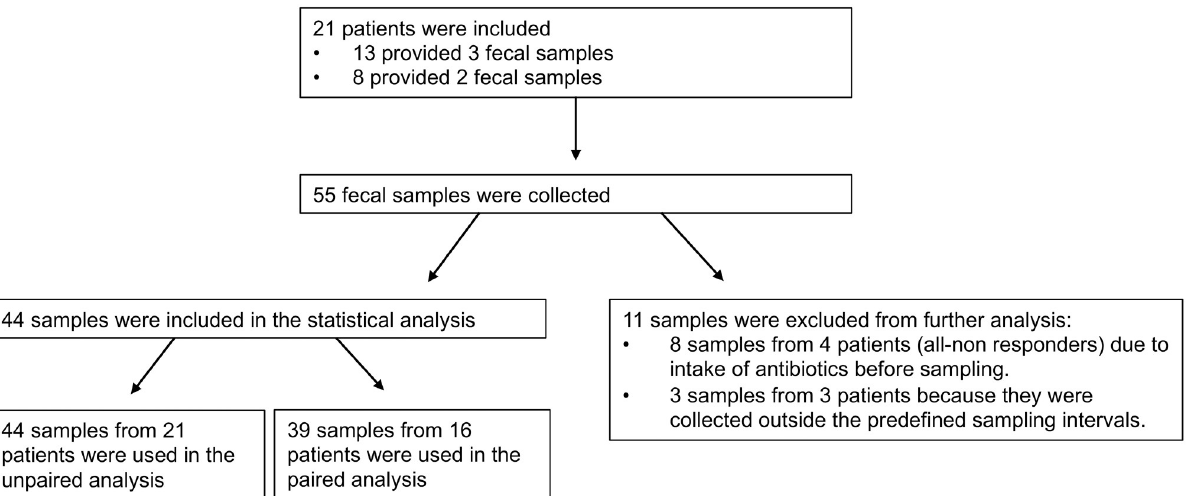
PLOS ONE | https://doi.org/10.1371/journal.pone.0249861 April 9,